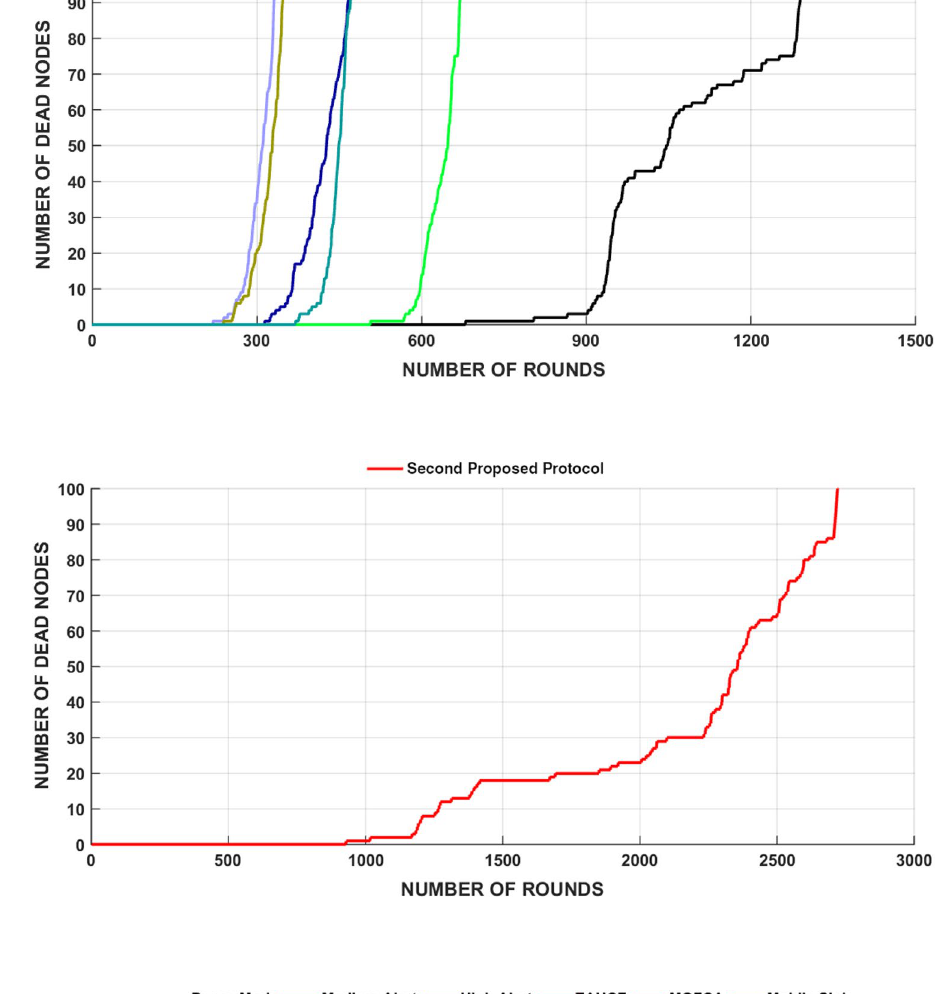
Fig. 15 Total remaining energy in relation to the number